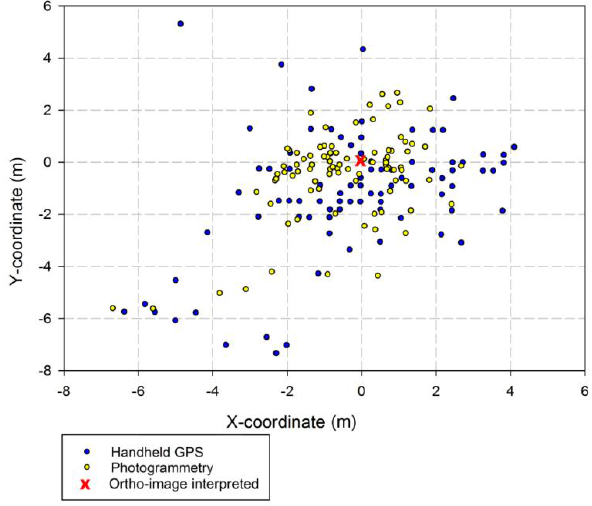
Figure 5. Comparison between handheld GPS and mobile photogrammetric X and Y coordinates relative to orthoimage-interpreted stem positions for urban sites.